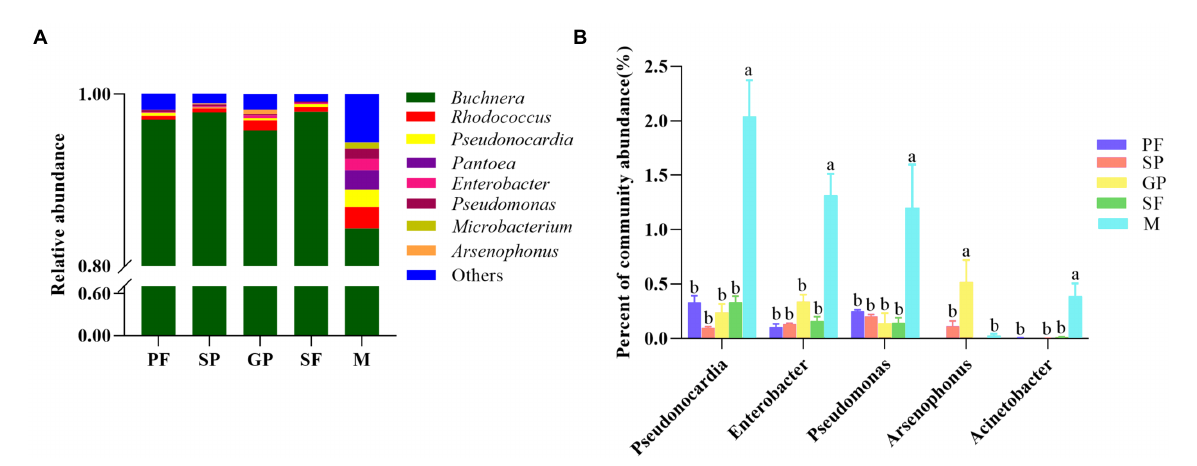
FIGURE 3 Relative abundance of microbial genera and its comparison across five reproductive morphs. (A) Relative abundance of major microbial genera in five reproductive morphs. (B) Comparison of relative abundance of five common secondary symbiotic bacteria in five reproductive morphs. Different lower-case letters represented significant differences ( p < 0.05) based on one-way ANOVA test. PF, parthenogenetic females; SP, sexuparae; GP, gynoparae; SF, sexual females; M,